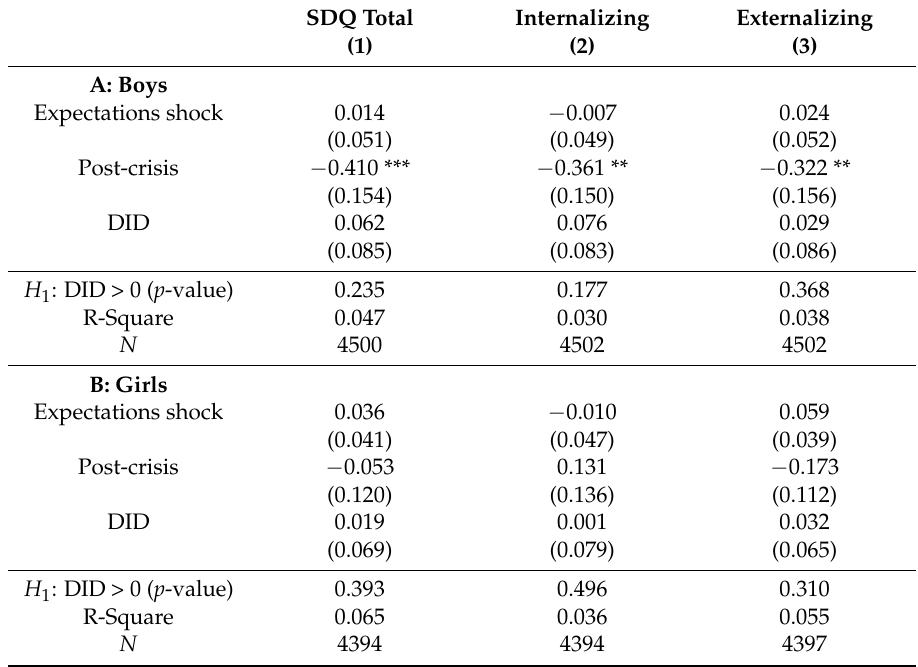
Table 2. The effects of unemployment expectations shocks (top 25th percentile) on teacher-rated SDQ outcomes, separately for boys and